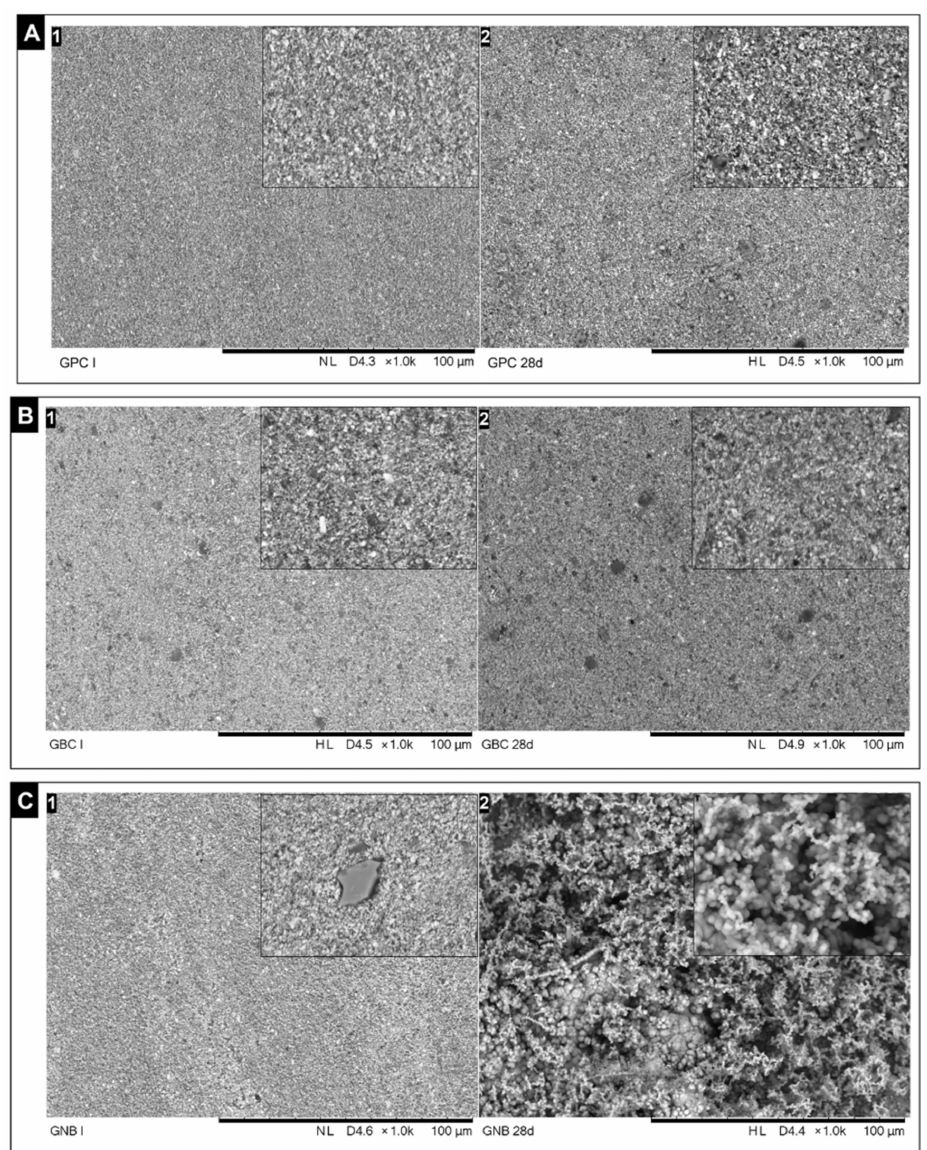
Figure 4. Representative SEM images before (1) and 28 days (2) after immersion in SBF of all evaluated groups. (Magnification: × 1000, scale: 100 µ m). ( A ) GPC group. Absence of precipitate formation on the surface of the material. ( B ) GBC group. Absence of precipitate formation on the surface of the material. ( C ) GNB group. 1—in the initial images, glass particles containing niobium on the surface of the material were present. 2—after 28 days immersed in SBF, a large volume of precipitates indicative of bioactivity on the surface was